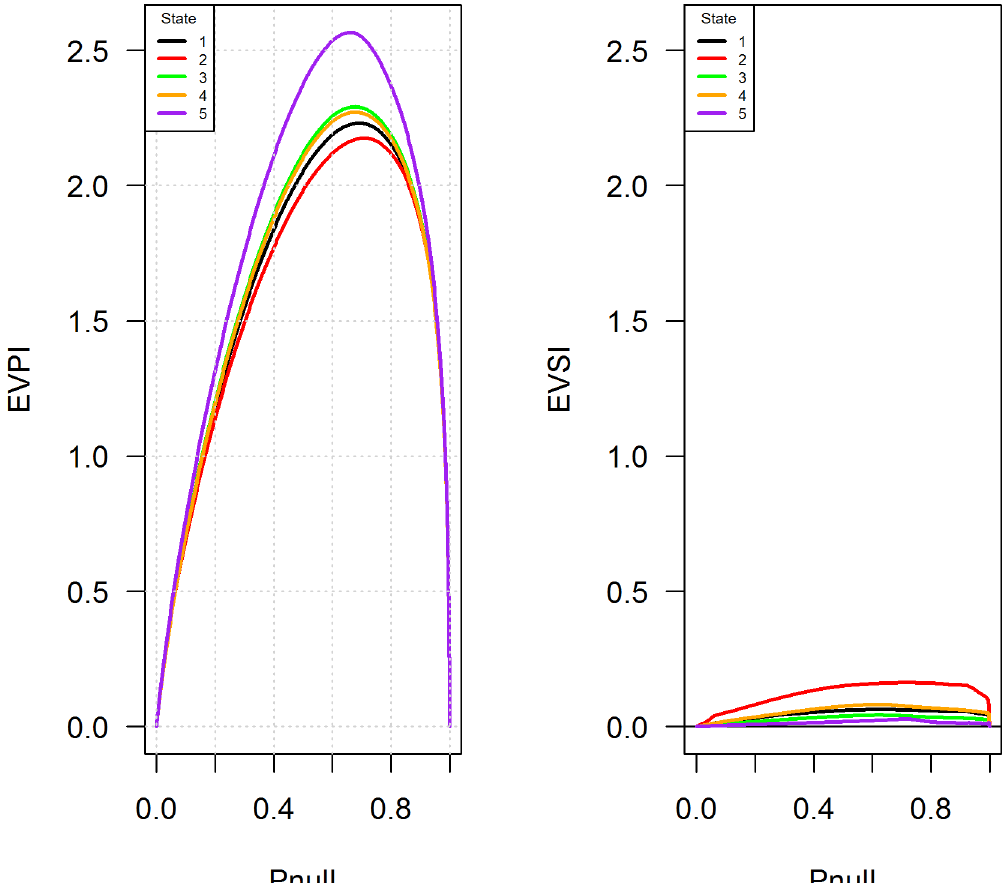
Fig 3. Left panel: The Expected Value of Perfect Information ( EVPI ) for eliminating uncertainty about the most appropriate model governing the effects of fire on habitat for Florida scrub-jays. Right panel: The Expected Value of Sample Information ( EVSI ) resulting from the use of an experimental, intensive burn. Scrub states are: (1) short-open; (2) short-closed; (3) optimal-open; (4) optimal-closed; and (5) tall-mix. Pnull is the probability of the null model, which posits that an intensive burn is no more effective at restoring optimal height scrub than a routine